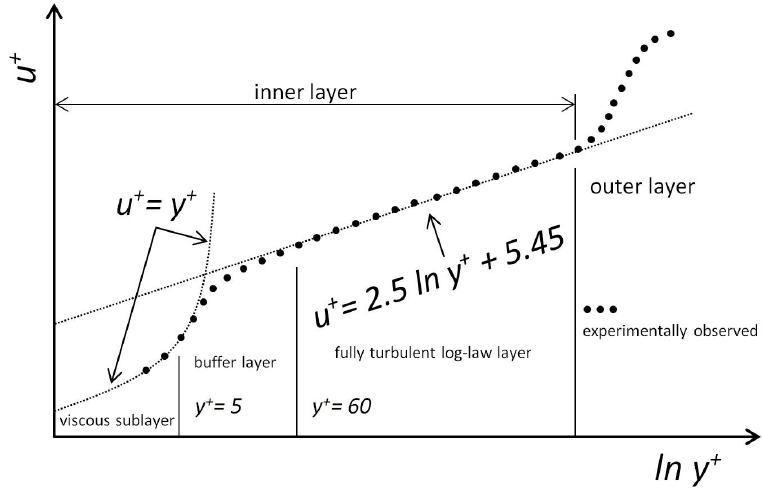
Figure 3. The law of the wall (adapted from ANSYS